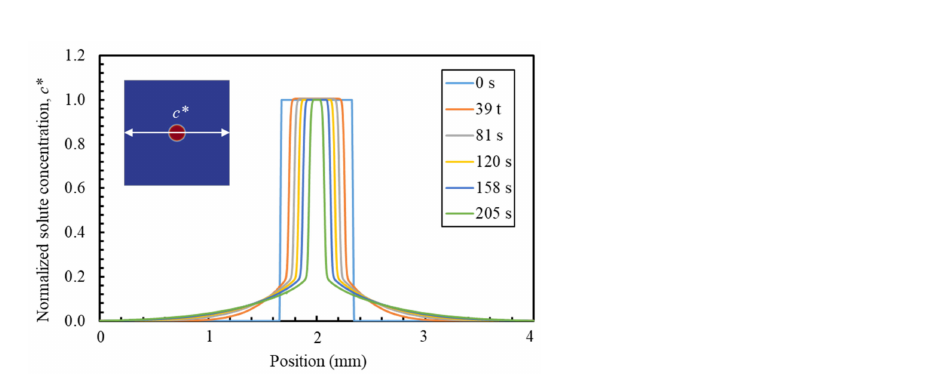
Figure 10. Concentration profiles of single NaCl spherical particle along radial direction with time.